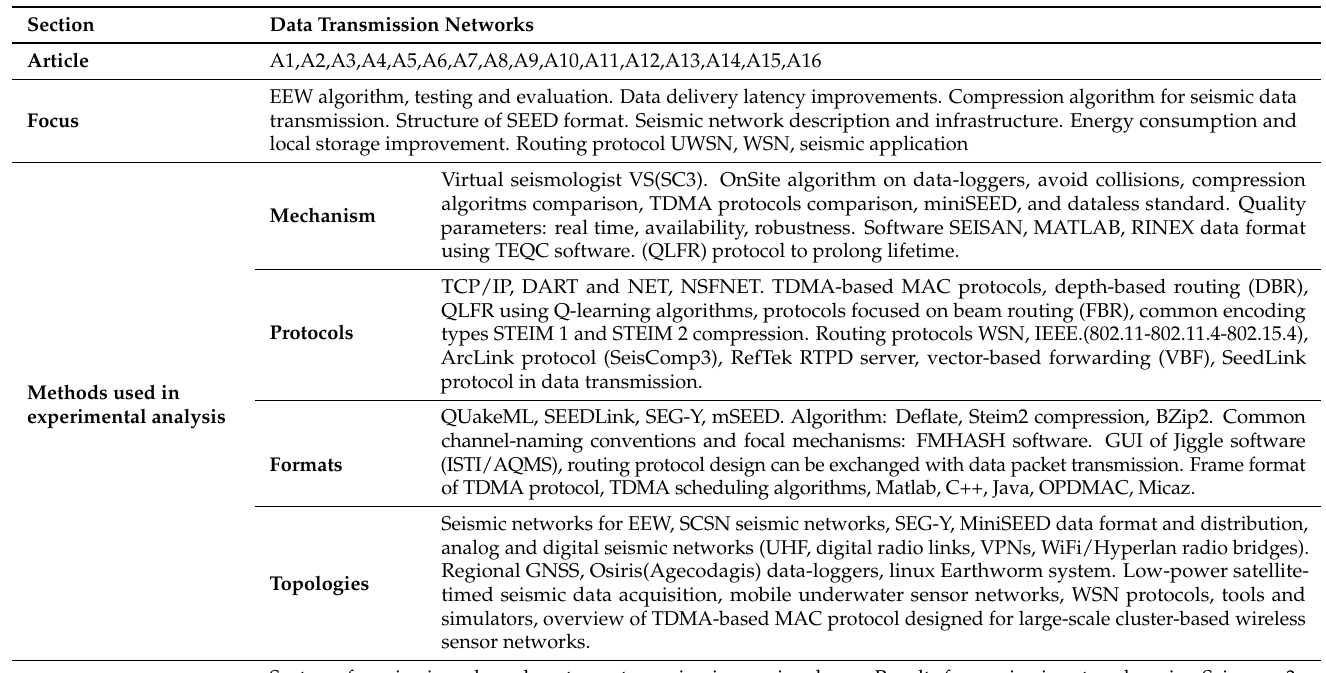
Table 4. Data Transmission